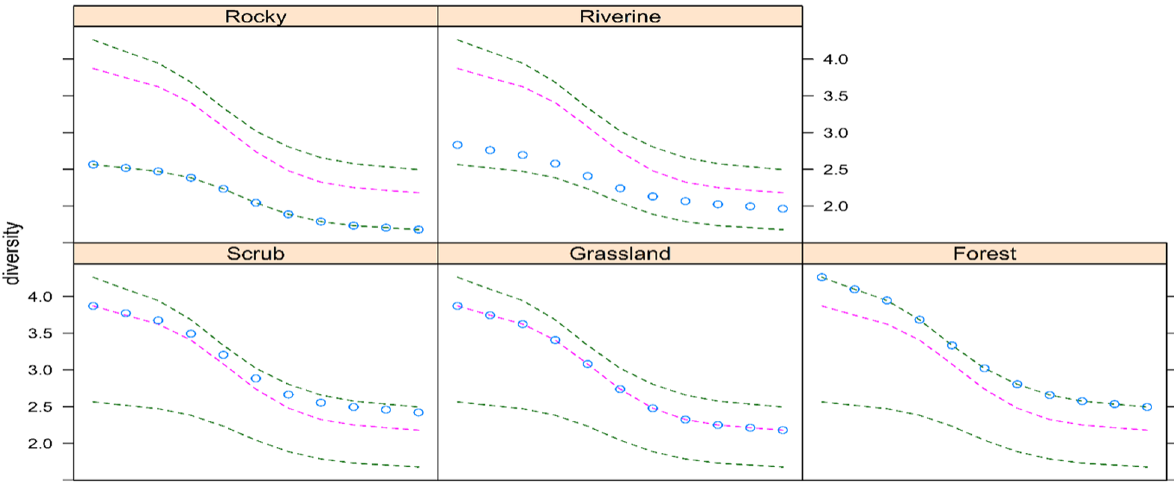
Fig. 2 Renyi diversity profiles of birds in the studied five vegetation or land use types based on the Trellis graphics with a separate panel for each vegetation or land use category. The dots denote the diversity value for the vegetation or land use types, the outer two dashed lines the extremes and the inner pink line the median in the